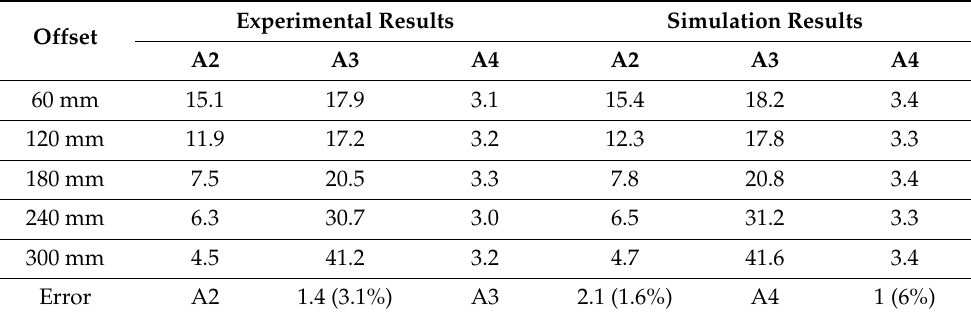
Table 11. Magnetic field strength at different offsets